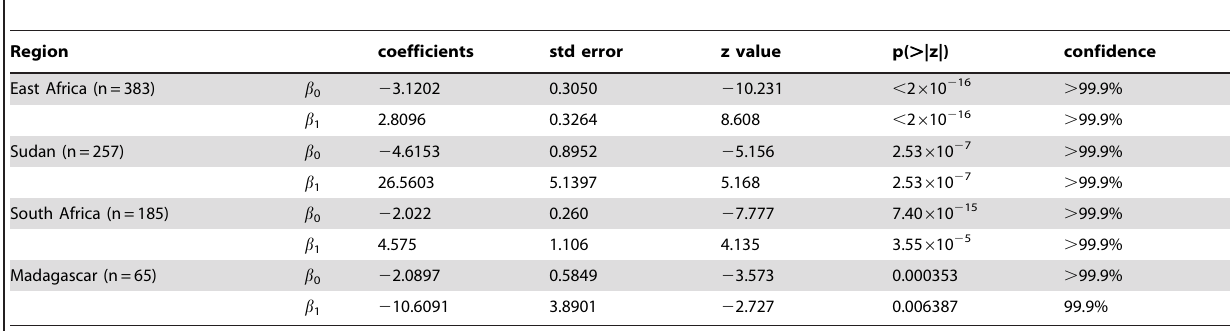
Table 2. Results of logistic regression of Rift Valley fever presence/absence on cumulative rainfall anomalies.